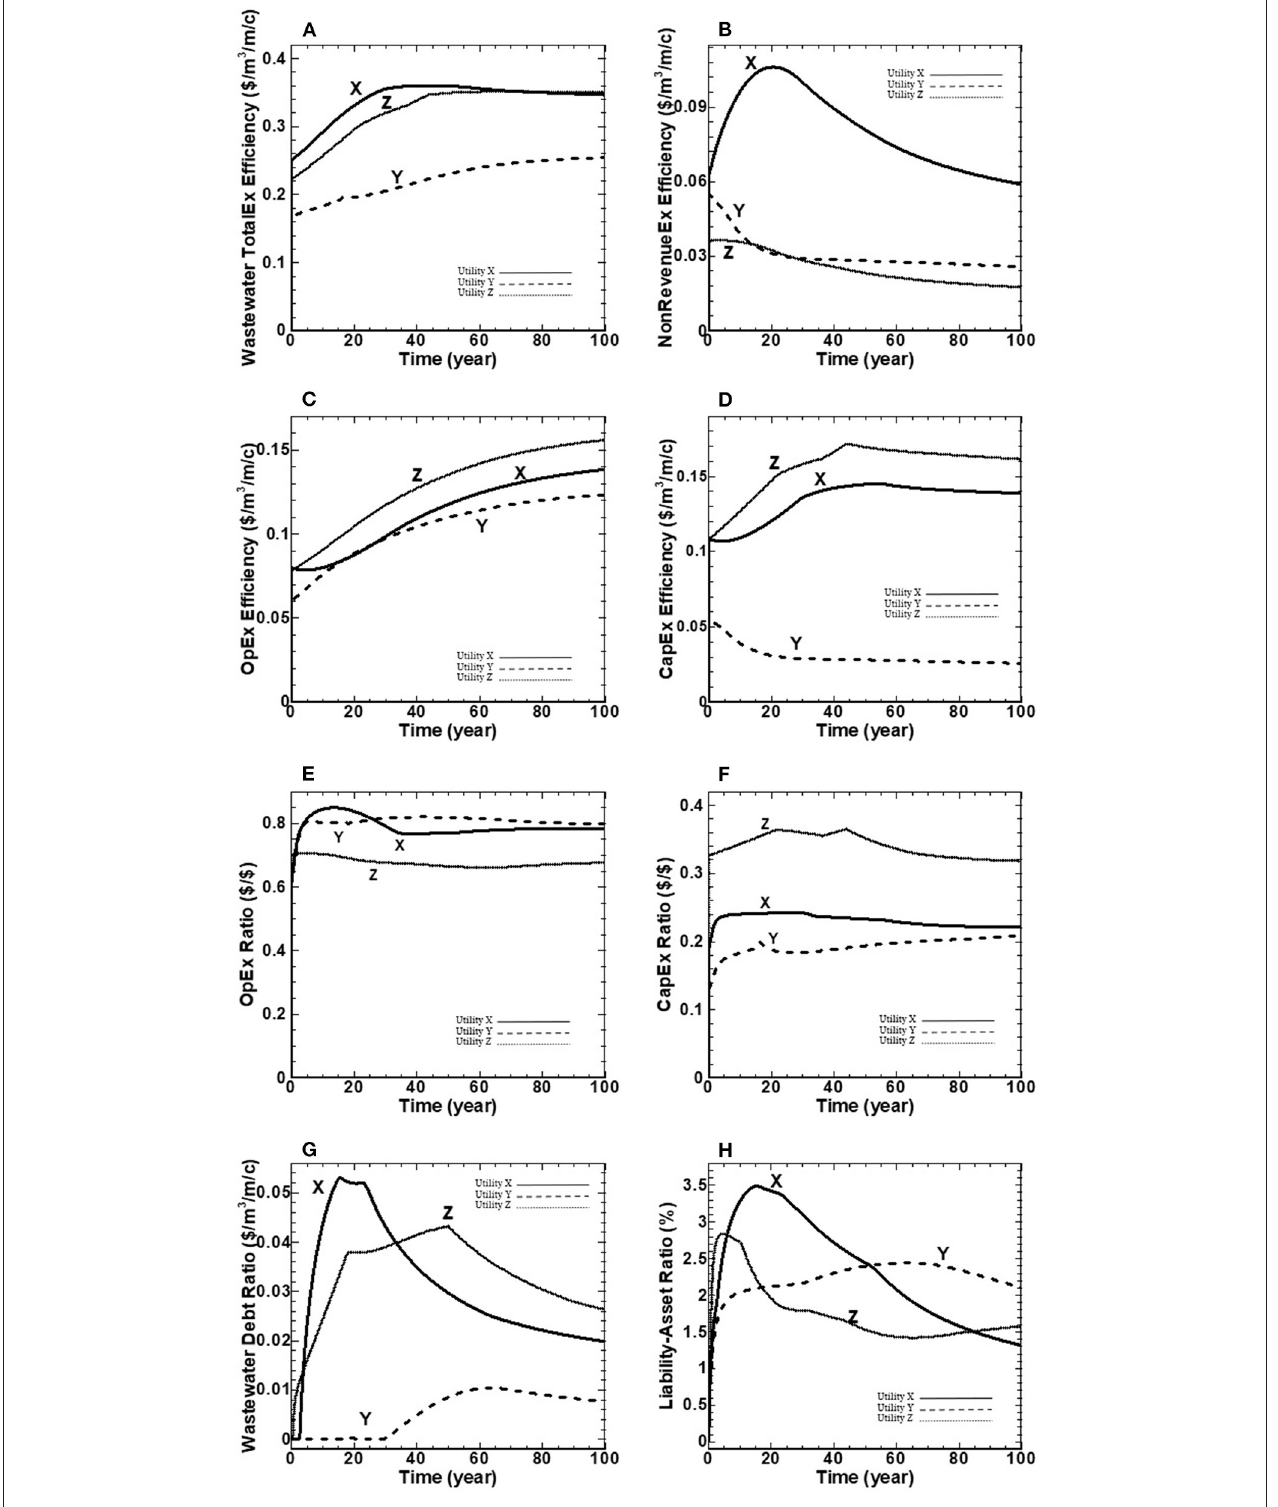
FIGURE 5 | (A–H) Wastewater financial performance indicators over a 100-year benchmarking period.